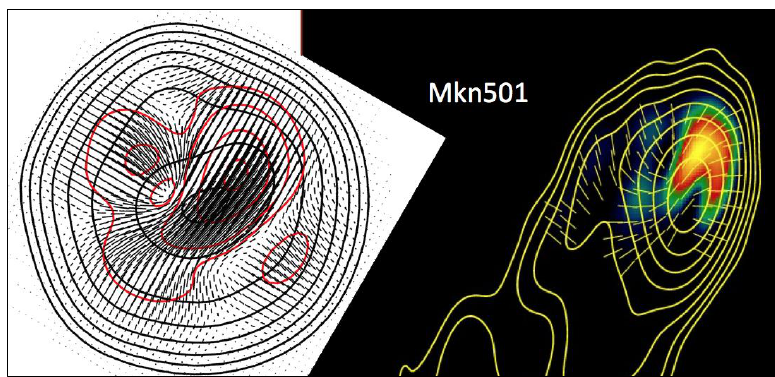
Figure 3. Left: Simulated millimeter-wave image of a conical standing “recollimation” shock, made with the author’s turbulent extreme multi-zone (TEMZ) code [57], in which turbulent plasma crosses the shock, becoming compressed and energized. Black contours represent total intensity, red contours polarized intensity; black line segments are the linear polarization E-vectors. Contours are 1%, 2%, 4%, 8%, 16%, 32%, 64%, and 95% of the peak intensity. Right: VLBA image of the BL Lac object Mkn501 at 43 GHz by the author and collaborators (program VLBA-BU-BLAZARS; see web page www.bu.edu/blazars/VLBAproject.html) in July 2015. Yellow contours: Total intensity, with levels 0.5%, 1%, 2%, 4%, 8%, 16%, 32%, and 64% of the peak; color: Polarized intensity; yellow line segments denote direction of the polarization E-vector. Note the similarity between the simulated and actual images both in the pattern of the E-vectors and the upstream displacement of the peak of the polarized relative to the total intensity. (The simulated image has been rotated so that its orientation is similar to the jet of Mkn501.)